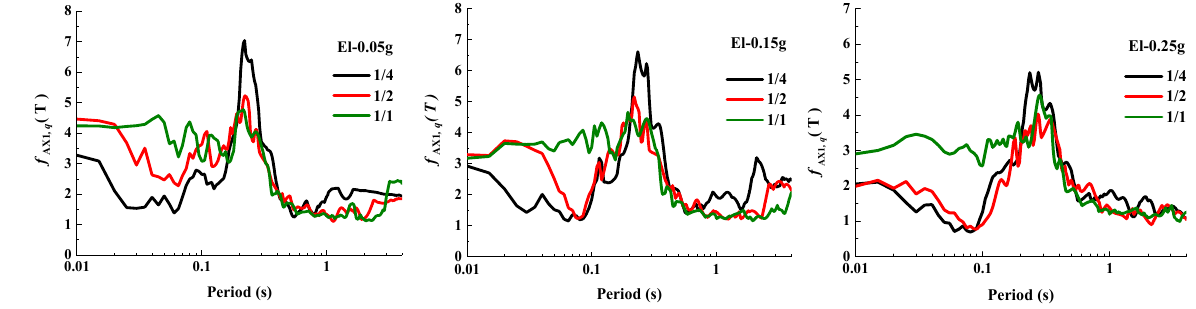
Figure 19. Transfer functions of measuring point AX1 under scaled Wolong records. 3.5.3. Influence of the Duration Compression Ratio on the Model Structure Comparisons of the acceleration amplification ratios and the transfer functions show that: (1) The spectral characteristics of ground motion had a great influence on the accel- eration response of the model structure. Under Wolong records with different duration compression ratios, the acceleration responses of the model structure were quite different. (2) On the whole, the acceleration responses of the model structure were relatively close when the time similarity ratios were 1/4 and 1/2. (3) Near the period corresponding to the first-order frequency of model structure, the amplitude of transfer function with the du- ration compression ratio of 1/4 was the largest. For the soil–pile–bridge structure system, the ground motion was transmitted to the structure through the model soil. Although the model soil had filtering and amplification effects on the ground motion, the input motions compressed by the time similarity ratio of model structure caused a larger response. Although SSI affects the seismic response of the structure, if the research focus is on the seismic response of the structure and the parts prone to damage in the earthquake, the input motions should be compressed by the time similarity ratio of model structure. 4. Conclusions A series of shaking table tests of the soil–pile–bridge structure system were carried out. Different intensities and spectral characteristics of input motions were considered